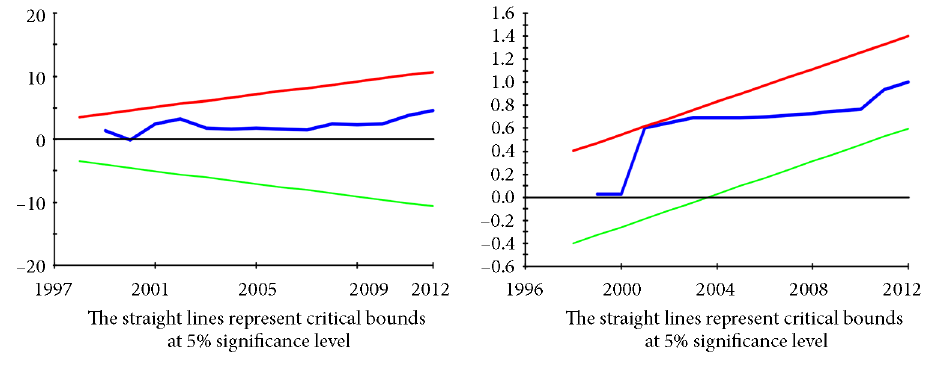
Figure 3. CUSUM and CUSUMQ